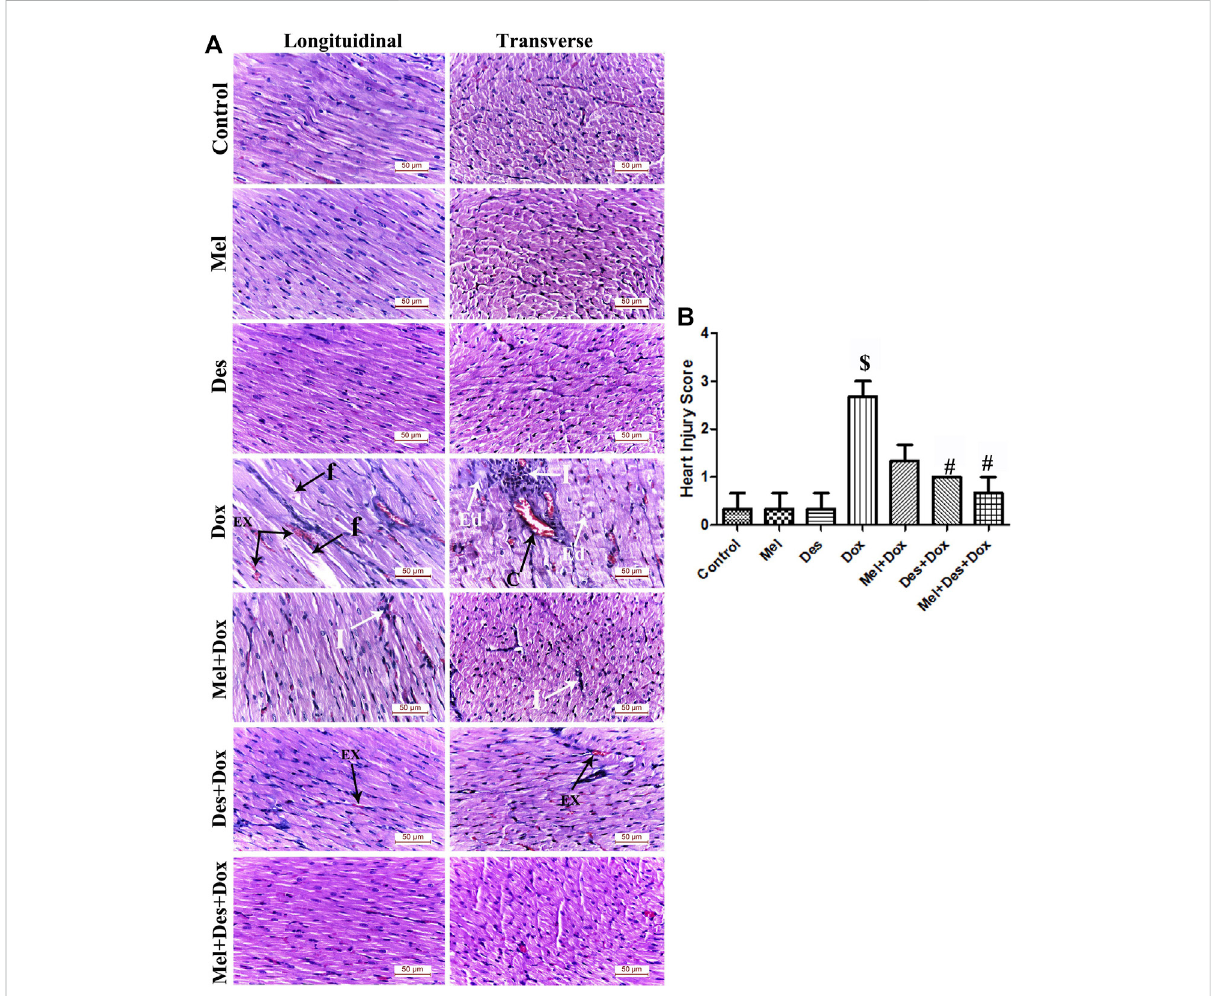
FIGURE 3 (A) Representative fi guresofH&E-stainedsectionsofthedifferentstudygroupsdisplayingnormalcardiacmyocytesinthecontrol,Mel,andDes groups. The Dox group shows focal degeneration of the cardiac muscle fi bers with cardiomyocyte fragmentation (f) and blood extravasation (Ex). Granulation tissue in fi ltrated with dense in fl ammatory in fi ltration (I) formed of lymphocytes, neutrophils, and macrophages is also observed. Dilated congested capillaries (C) and interstitial edema (Ed) in-between the disrupted cardiomyocytes are also observed. The Mel-Dox group shows minimal myocyte disruption with residual mononuclear in fl ammatory cellular in fi ltration (I). The Des-Dox group shows regularly arranged cardiac muscle fi bers with minimal blood extravasation (Ex). The combined Mel-Des-Dox group shows improved architecture of the cardiac muscle fi bers where they exhibit normal acidophilic sarcoplasm, central oval vesicular cardiomyocyte nuclei, and peripheral fl at spindle-shaped nuclei of fi broblasts. The cardiomyocytes appear separated by narrow inter- fi brillar spaces and healthy blood capillaries. (Scale bar 50 µm). (B) Heart injury score of the different study groups. ($: signi fi cant versus control, #: signi fi cant versus Dox, @: signi fi cant versus Mel-Dox, *: signi fi cant versus Des- Dox at p < 0.05, (n = 10) using ANOVA and Tukey ’ s post hoc test for pairwise comparison.). Mel: melatonin; Des: deferoxamine; Dox: